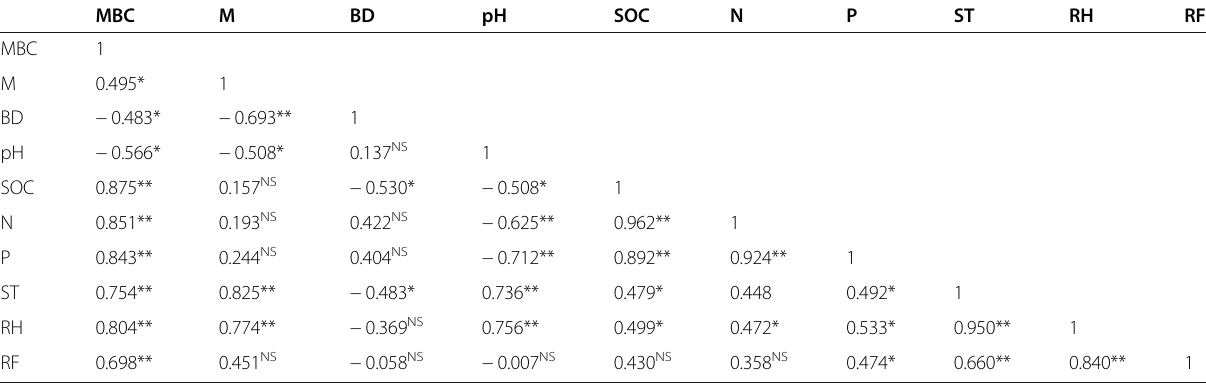
Table 3 Pearson correlation coefficient between soil microbial biomass and soil characteristics MBC M BD pH SOC